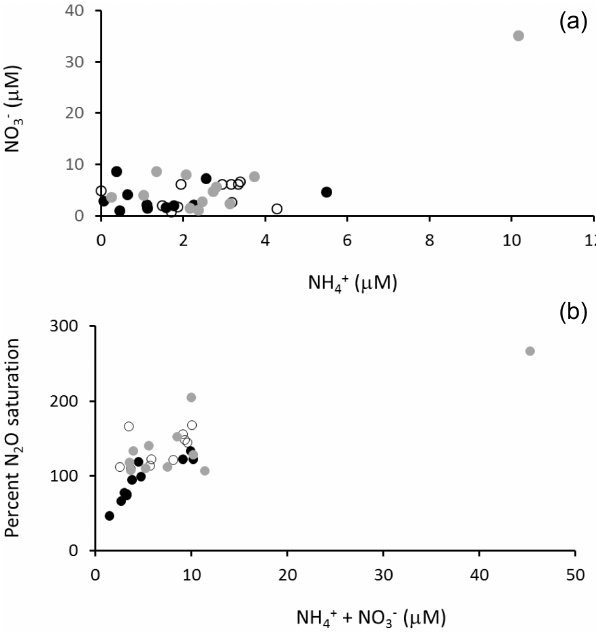
Figure 3. (a) Dissolved nitrate vs. dissolved ammonium and (b) percent nitrous oxide saturation vs. DIN (NO − of the Republic of Congo during the wet season: open circles, sa- vannah rivers; filled black circles, swamp forest rivers; filled grey circles, tropical forest